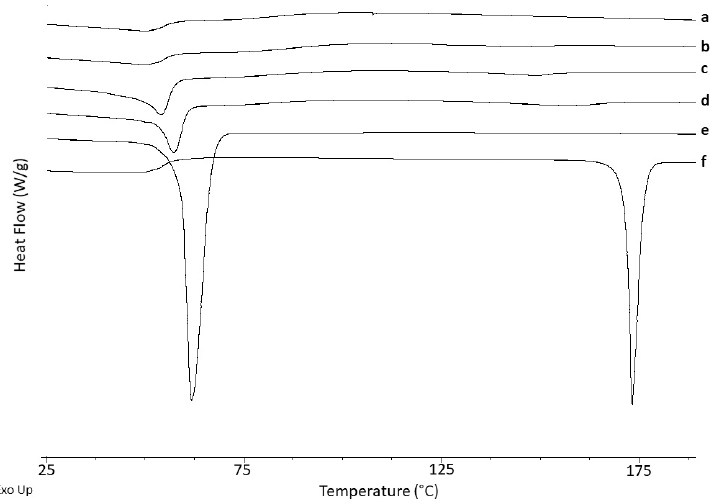
Figure 4. DSC thermograms. Key: ( a ) Unprocessed HPC, ( b ) Unprocessed HPMCAS, ( c ) 3D printed minitablets, ( d ) Physical mixture, ( e ) Unprocessed PEG 4000, and ( f ) Unprocessed NFD.